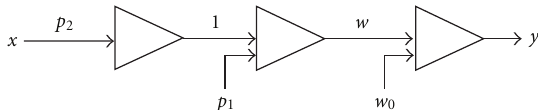
Figure 1: The model used for approximating the function y = ax + b